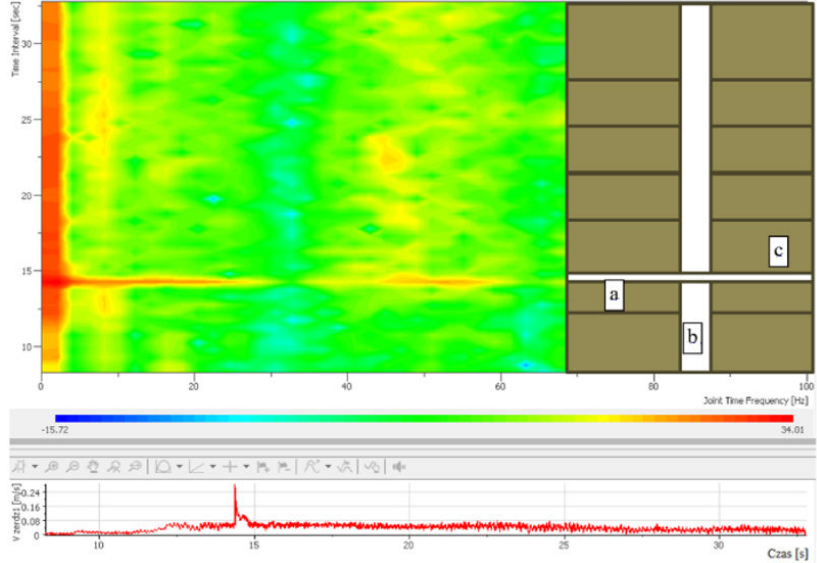
Figure 17. The detected signal on the recorded spectrogram corresponding to the location the critical discontinuity for borehole 1, rod 1—Hanning window, time domain sieve set to 50 dB scale; a, rock layer; b, borehole; c,